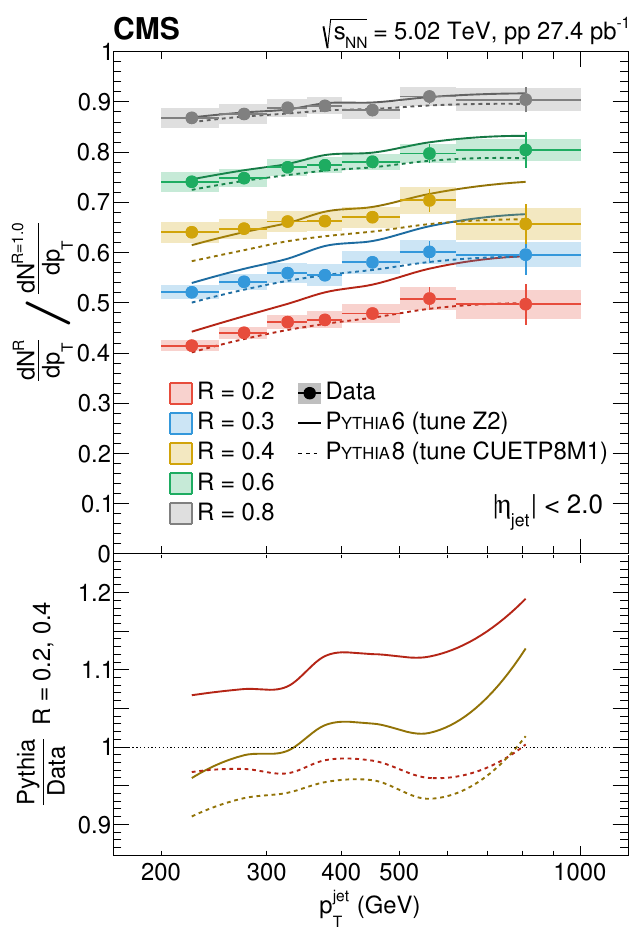
Figure 6 . The spectra ratio for jets from pp collisions with | η jet | < 2 . 0 for R = 0 . 2 – 0 . 8 with respect to R = 1 . 0 . The statistical uncertainty of data is shown as vertical lines, whereas the systematic uncertainties are shown as the shaded boxes. Markers for the data are placed at the bin centers. Comparisons with pythia 6 (solid line) and pythia 8 (dotted line) are plotted, along with ratios in the lower plot for R = 0 . 2 and R = 0 . 4